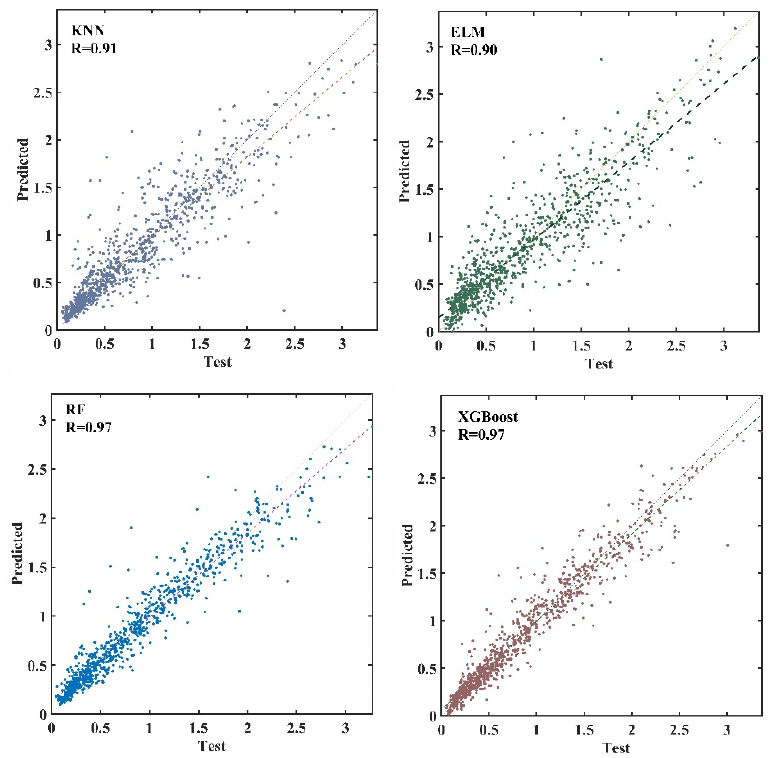
Figure 3. Characteristics of test results of four models.